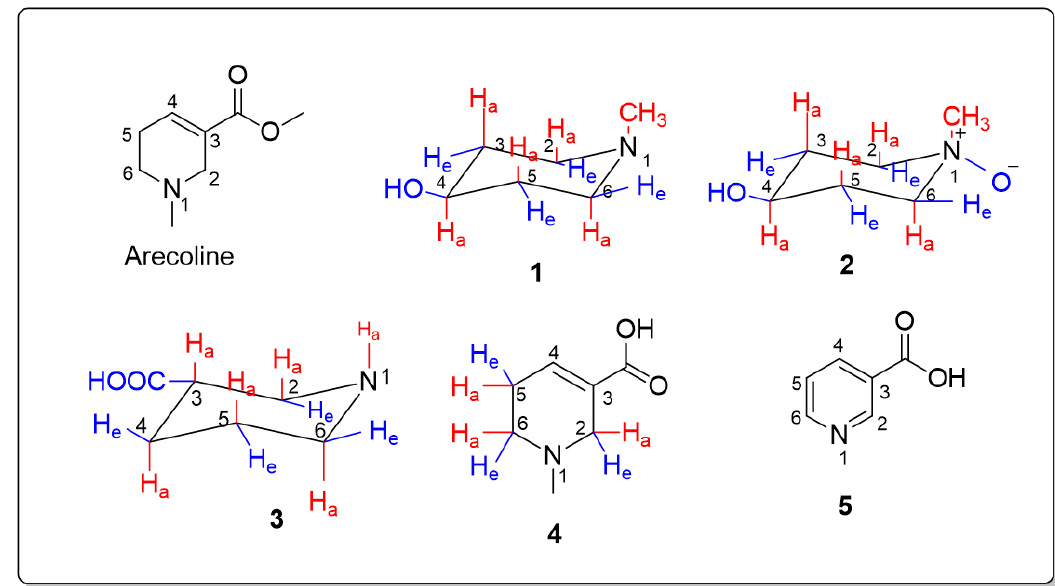
Figure 1. Chemical structures of arecoline and isolated compounds 1 – 5 . Compound 2 : The DEPTQ NMR spectrum (D 2 O) yielded four signals corresponding to six carbons. Signals at δ C 27.5 and 61.6 represented two magnetically equivalent carbons for each. The signal at δ C 61.2 for a methine carbon suggested oxygenation and was assigned to C- 4, while the signal at δ C 58.1 proposed N-CH 3 (Figure S9). Because of the nitrogen atom and the hydroxyl group, as discussed in compound 1 , the signal at δ C 27.5 for a methylene carbon was assigned to C-3 and C- 5, while the signal at δ C 61.6 for a methylene carbon was assigned to C-2 and C-6. These data suggested a 1,4-disubstituted ring which was confirmed by the 1 H NMR spectrum. The 1 H NMR data (D 2 O) of compound 2 (Figure S10) revealed axial and equatorial protons at the positions C-2, C-6, C-3, and C-5, which were assigned with the aid of COSY and HSQC analysis as in compound 1 . It showed two multiplet signals at δ H 3.03 and 3.43, each integrating for two protons, assigned to the axial and equatorial protons H-2a,6a, and H-2e,6e, respectively. A singlet peak at δ H 3.06 was integrated for three protons corresponding to N-CH 3 . The multiplet signals at δ H 1.59 and 2.06, each integrating for two protons, were assigned to the axial and equatorial protons H-3a,5a and H-3e,5e, respectively. A multiplet signal at δ H 3.95 was integrated for one proton corresponding to the proton at C-4. The 1 H- 1 H COSY correlation confirmed the proposed assignment of protons. The H-4 proton was correlated to the axial protons at C-3 and C-5, which indicated that the hydroxyl group is equatorial. Additionally, the axial protons at C-3 and C-5 showed a strong correlation to the equatorial geminal protons at the same carbons and to the axial protons at C-2 and C- 6, respectively. Weak correlations were observed for the equatorial protons at C-3 and C-5 to H-4 and to the axial protons at C-2 and C-6. The equatorial protons at C-2 and C-6 exhibited a strong correlation to the axial geminal protons at the same carbons, a strong correlation to the equatorial protons at C-3 and C-5, and a weak correlation to the axial protons at C-3 and C-5 (Figure S11). The DEPTQ and 1 H NMR correlation spectra indicated a correlation for H- 4 and δ C 61.2 (Figure S12). These data are consistent with those of compound 1. However, C-2, C-6, and N-CH 3 are more deshielded, indicating an electronegative substitution affecting these sites. The HMBC spectrum (Figure S13) revealed a correlation of the axial protons at C-2 and C-6 to the N -methyl carbon and the equatorial protons at C-2 and C-6 to C-6 and C-2, respectively. The HMBC analysis revealed a correlation of the axial protons at C-3 and C-5 to C-5 and C-3, respectively. The protons at C-3 and C-5 exhibited a correlation to C-4. The protons at C-2 were correlated to C-3, C-4, and C-6, and the protons at C-6 were correlated to C-4 and C-5. For the determination of the relative configuration, as in 1 , the NOE spectrum (Figure S14)